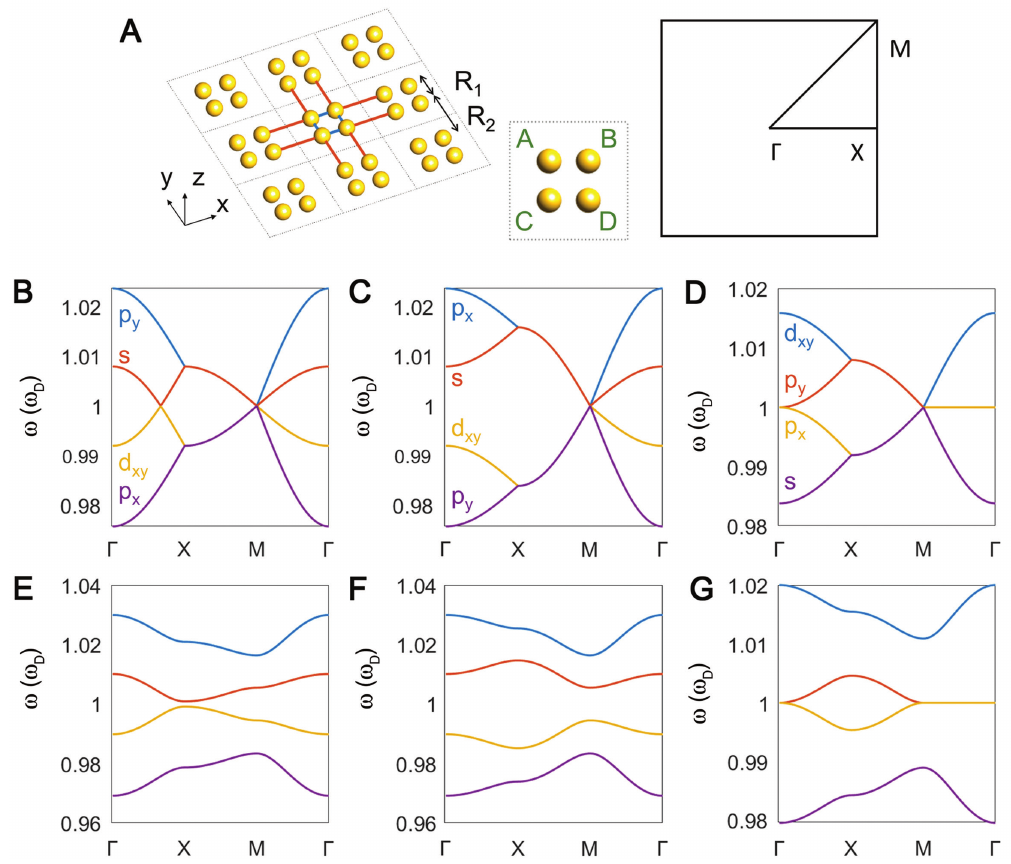
Figure 1: 2D photonic SSH model and its bulk dispersion. (A) Schematic of a 2D photonic SSH model composed of NPs and the first Brillouin zone with high-symmetry lines. Four sites of a unit cell are labelled as A , B , C , and D . Blue and red lines indicate intracellular and intercellular coupling, respectively. R intracellular and intercellular distance, respectively. (B–G) Bulk states along high symmetry lines when (B–D) R center, and right column correspond to x -, y -, and z -polarized modes,